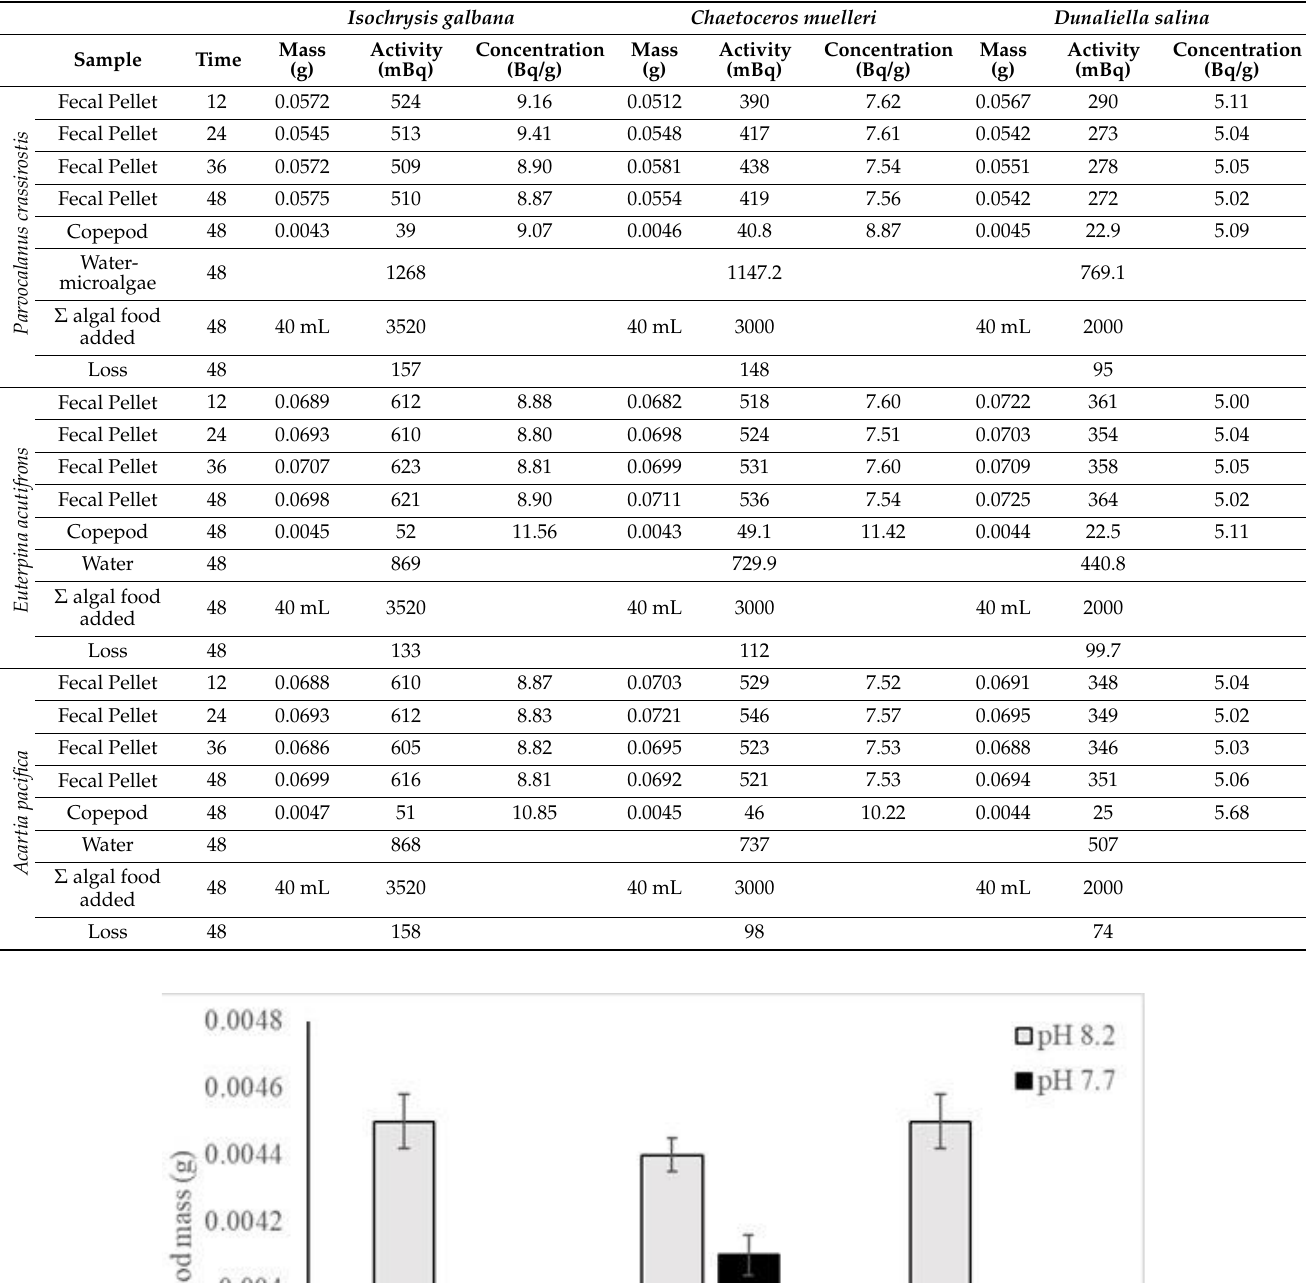
Table 4. 209 Po concentration in the experimental samples at 7.7 pH.